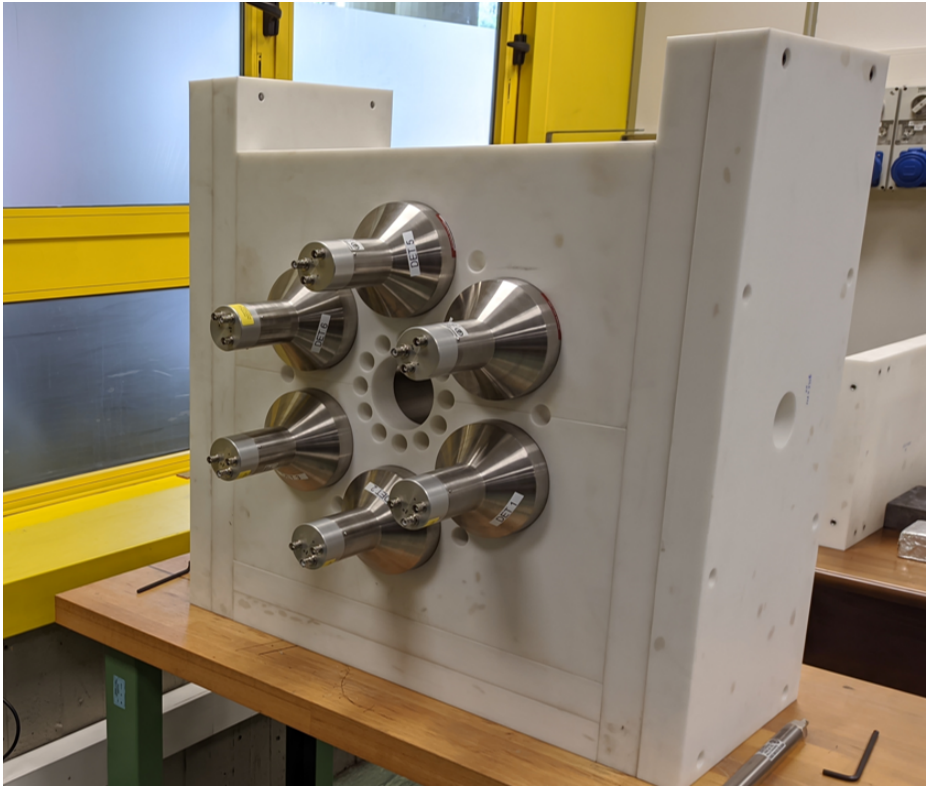
Figure 2. Mounting of the Shades detection array inside the borated polyetylene shielding